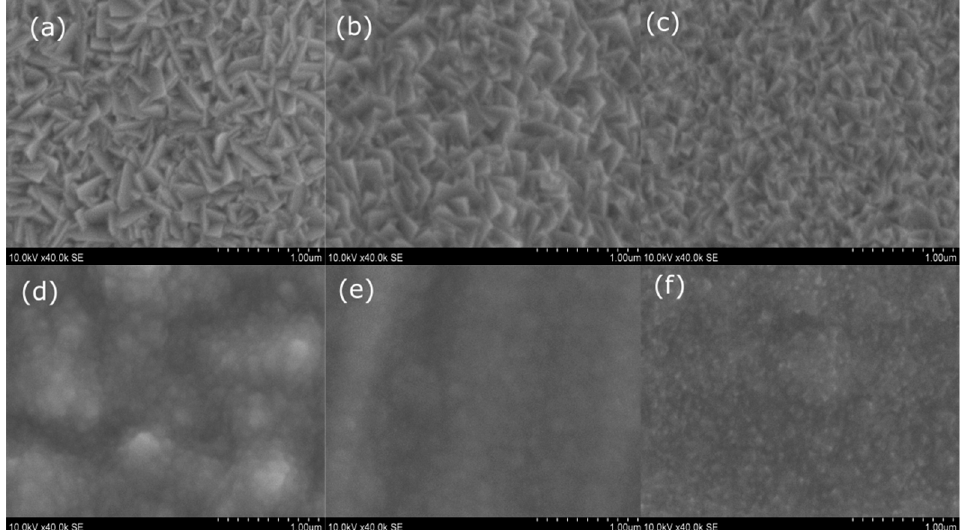
Figure 1. SEM images of the surface of the thin films: BCO ( a ), BCY10 ( b ), BCY20 ( c ), BZO ( d ), BZY20 ( e ), and BZCY ( f ).